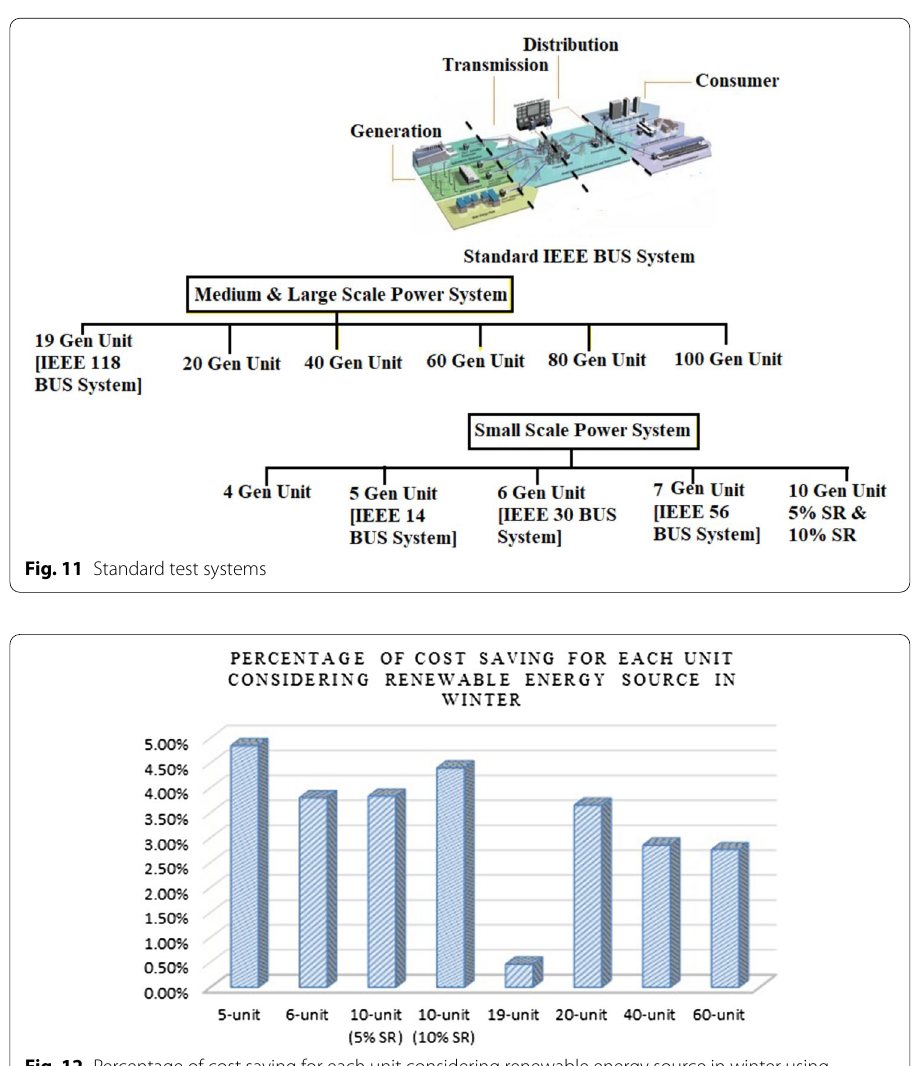
Fig. 12 Percentage of cost saving for each unit considering renewable energy source in winter using hHHO-SCA optimization